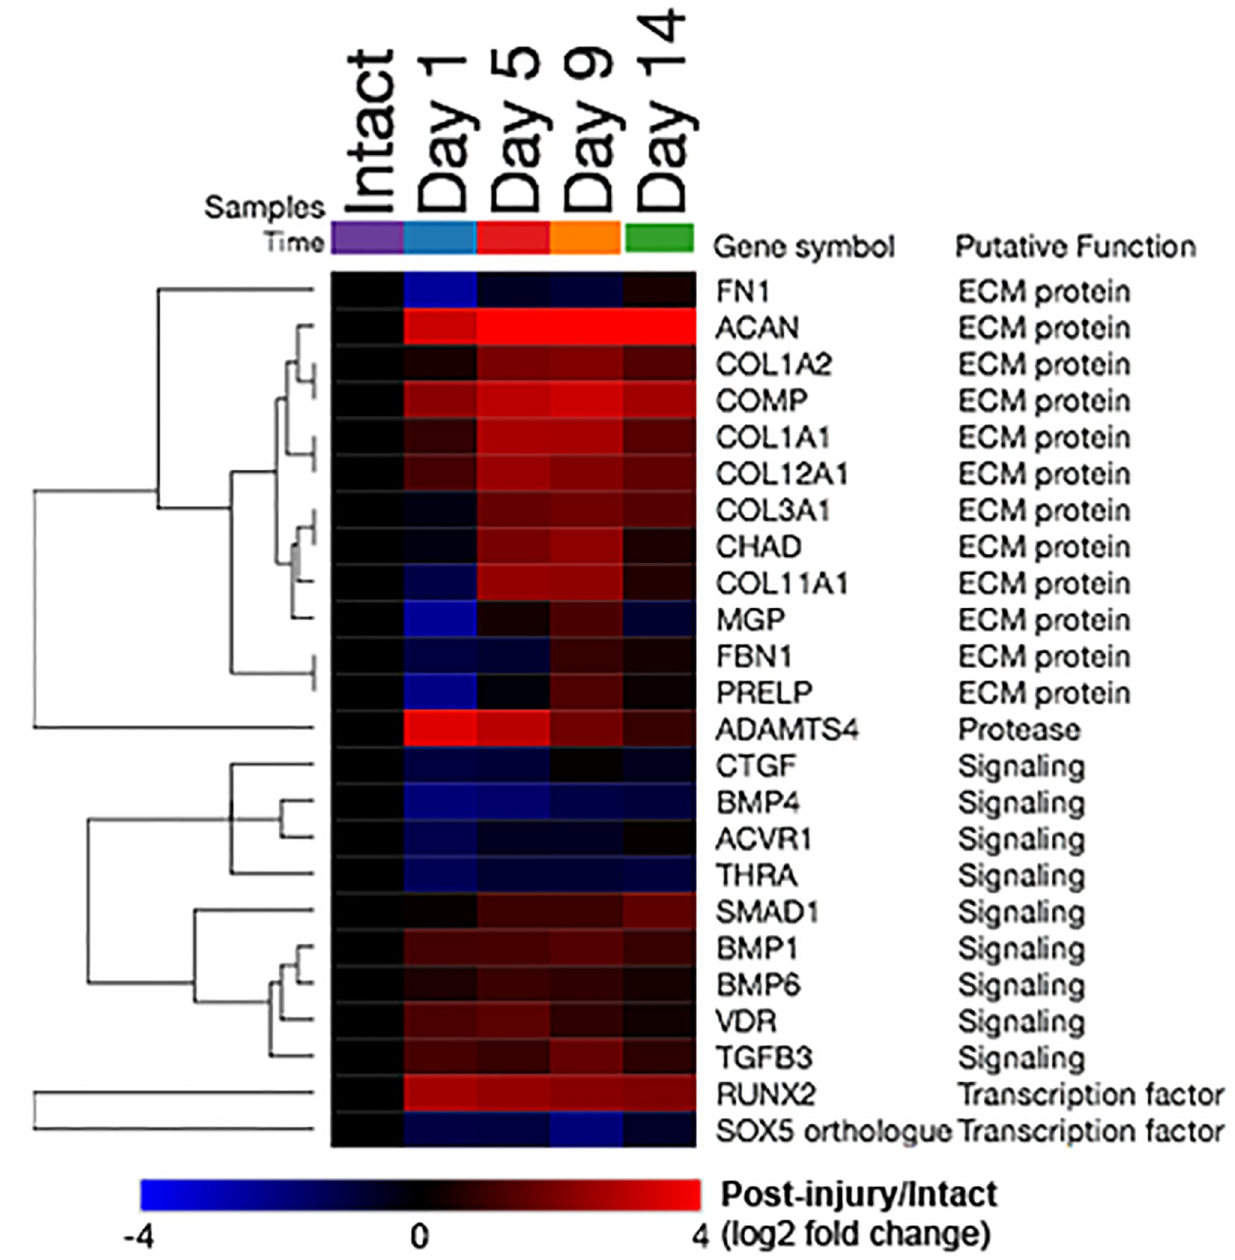
Fig 3. Cartilage development related gene expression changes (Development_Cartilage development process network). Heatmap depicting the relative transcript abundance levels compared to intact controls (log-2 fold change from the comparison of post-injury group means over the mean of the intact controls). Red indicates higher expression following injury, blue indicates lower expression, i.e. significant increases of ACAN at 1, 5, 9, and 14 days post-injury were observed. All 24 transcripts (rows) that are differentially expressed in at least one of the assessed post-injury time-points were included (out of 60 total transcripts included in the process